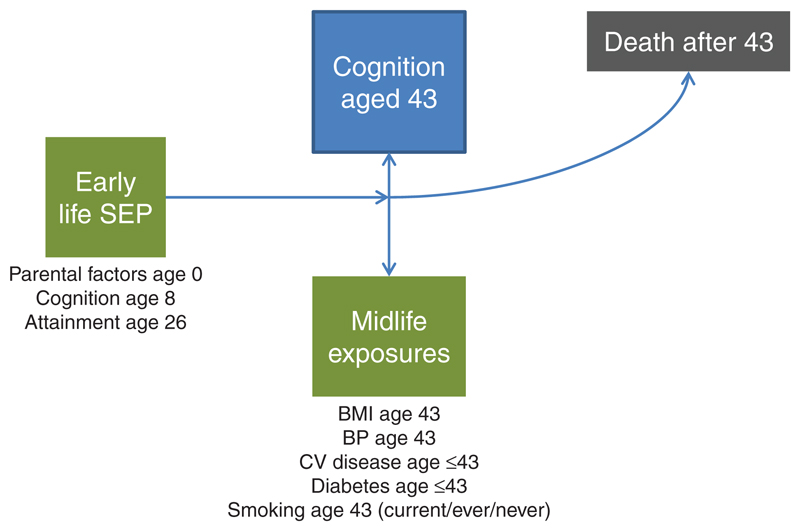
Schema outlining life course relationships contributing to analytical models.